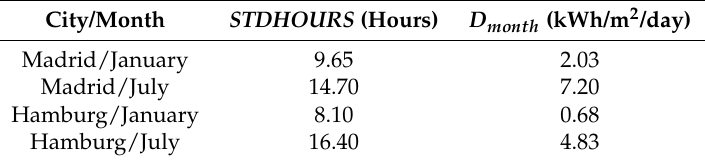
Figure 15. Irradiance curves for the cities of Madrid and Hamburg in January and July. Table 5. Daylight hours and solar irradiance parameters for Madrid (latitude: 40.437944; longitude: − 3.679536) and Hamburg (latitude: 53.558869; longitude: 9.927821) during the months of January and